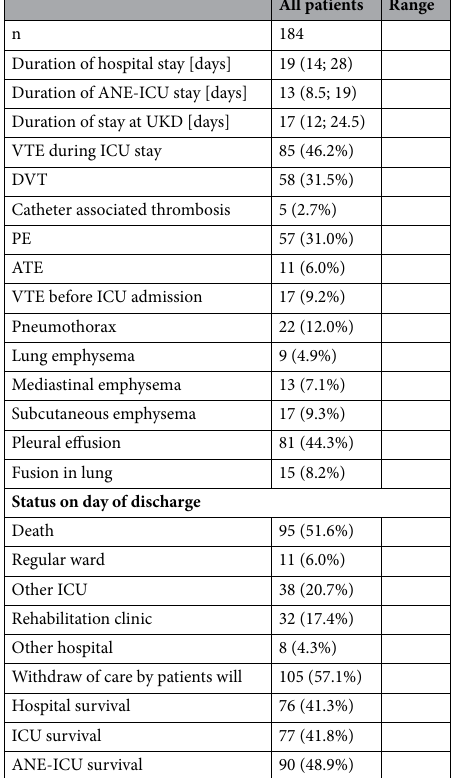
Table 3. Patients outcome all. Data are median (Interquartile range) or n (%). ICU Intensive care unit, ANE‑ ICU Intensive care unit of the Department of Anesthesiology and Critical Care Medicine, UKD